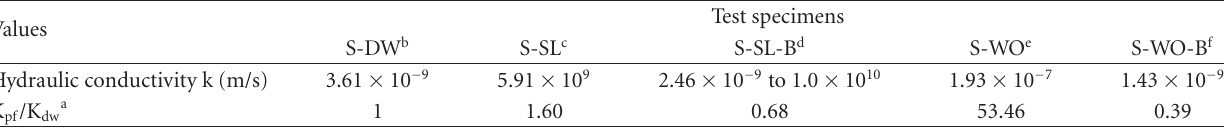
Table 4: Hydraulic conductivity values in the test specimens.